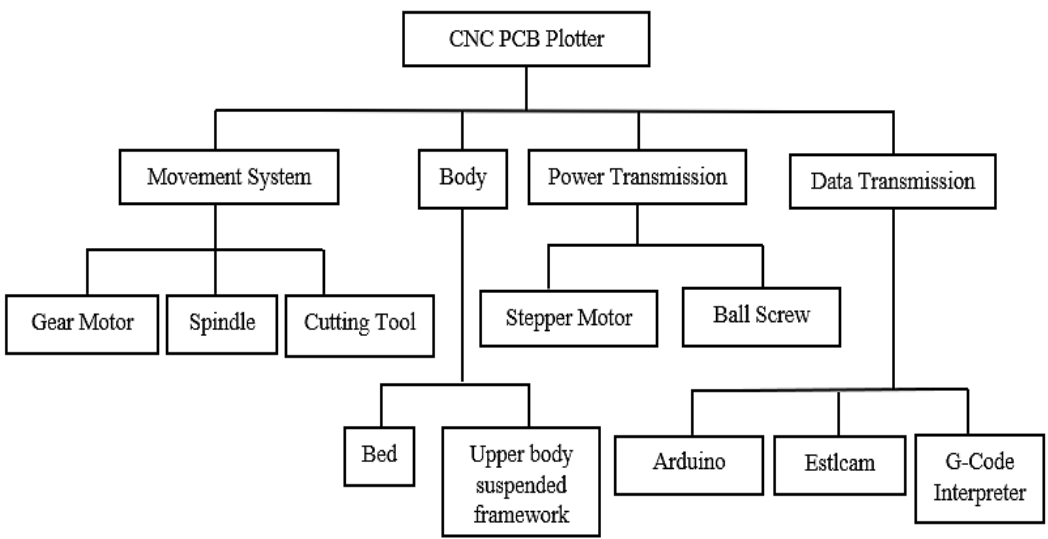
Figure 3. Component hierarchy for CNC PCB